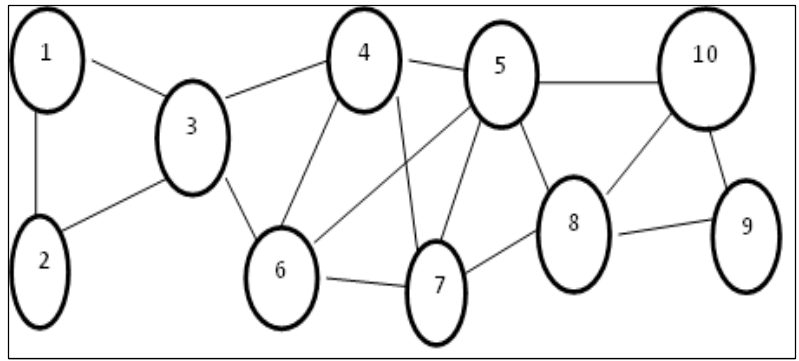
Figure 2. The vertex subsets {1, 6, 8}, {1, 4, 9}, {3, 8}, {3, 5, 9}, and {3, 7, 10} are few dominating sets of 𝐺